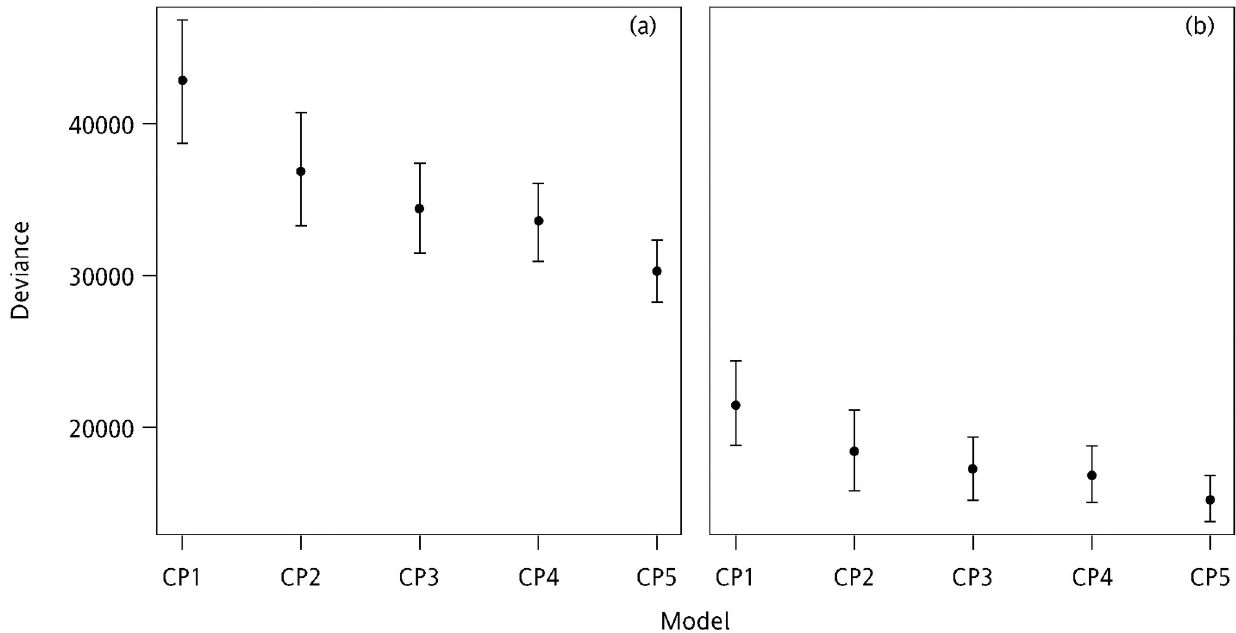
Fig 6. 95% PBLs of deviance based on the simulated (a) calibration and (b) validation sets for each